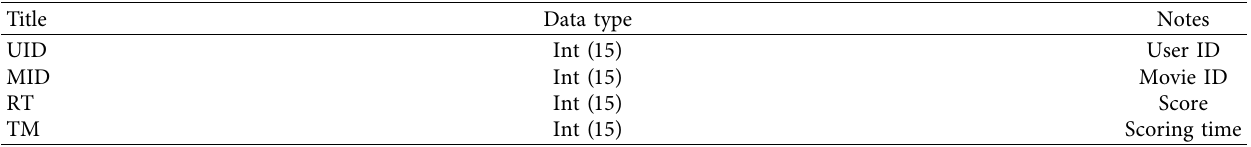
Table 4: Rating information data sheet.